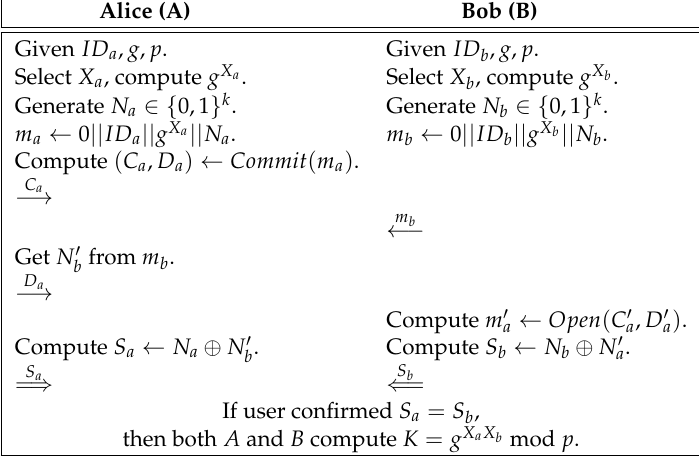
Figure 4. Taparia, Panigraphy, and Jena’s protocol